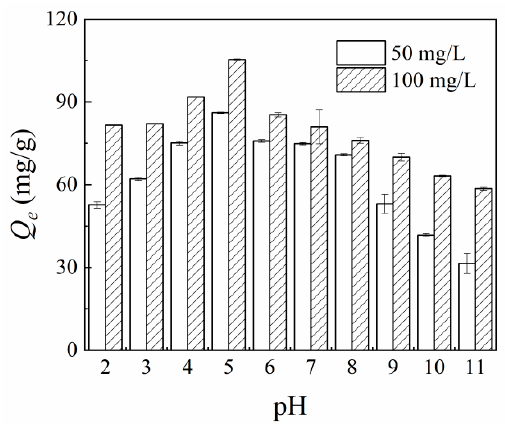
Figure 5. E ff ect of initial pH values on the adsorption of As(V). Figure 5. Effect of initial pH values on the adsorption of As(V). Table 3. Comparison of the As(V) adsorption capacity with some reported materials.